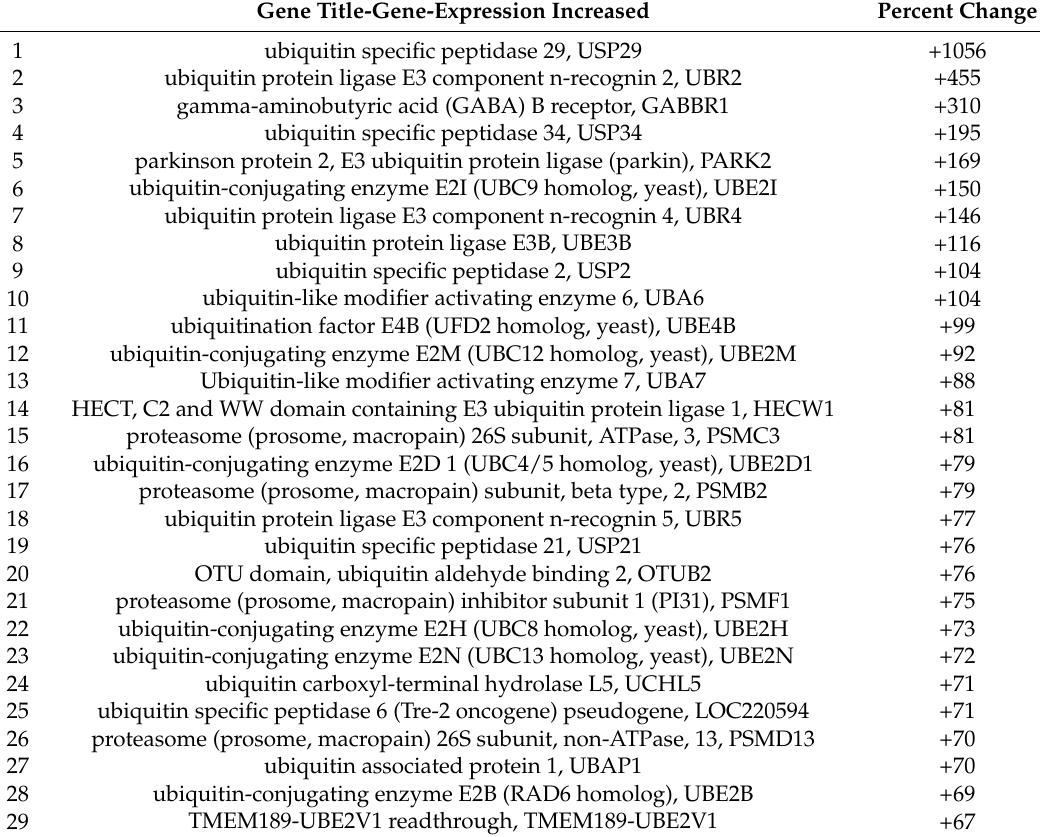
Table 3. GHK’s Effect on Gene Expression relevant to the Ubiquitin/Proteasome System [4]. Gene Title-Gene-Expression